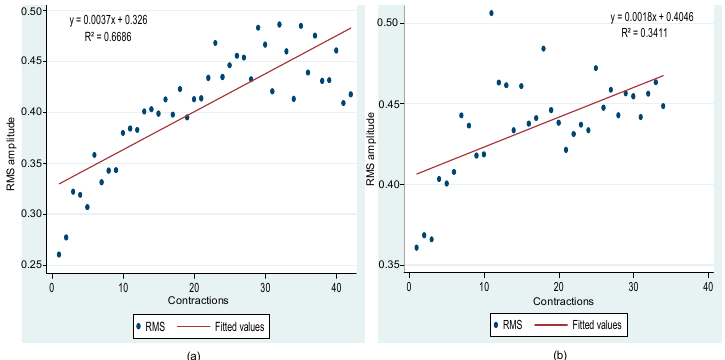
Figure 9. Results obtained with linear regression in the amplitude analysis for routine 2 in the vast external: ( a ) Player 2; ( b ) Player 6.